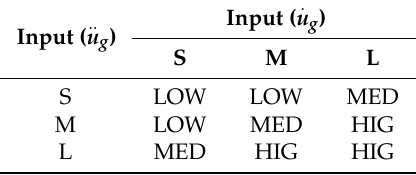
Table 5. Fuzzy rule base for S volt of supervisory FLC.